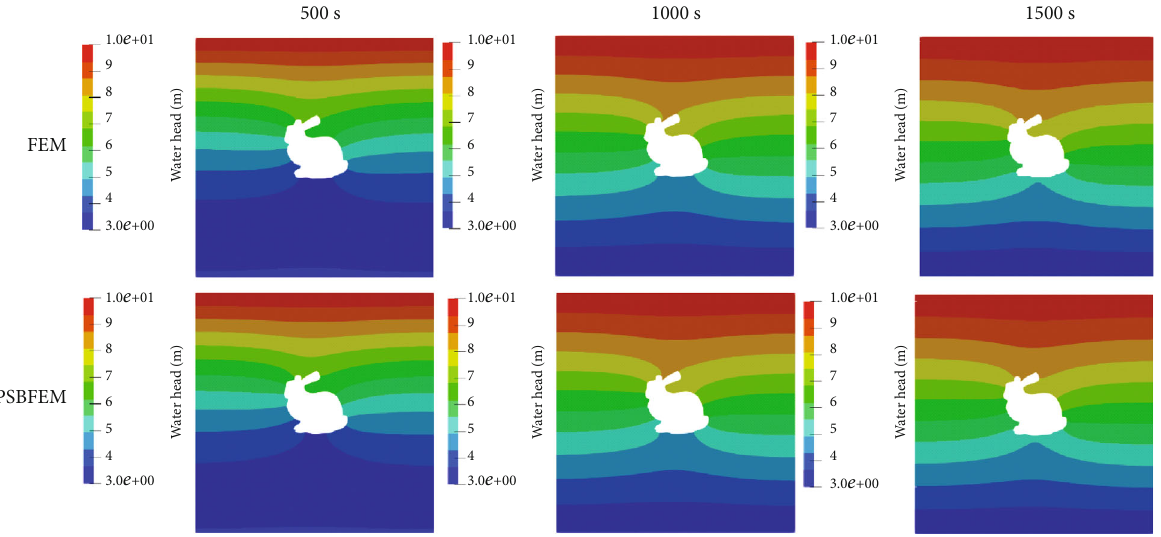
Figure 13: Water head distribution at di ff erent times using the FEM and